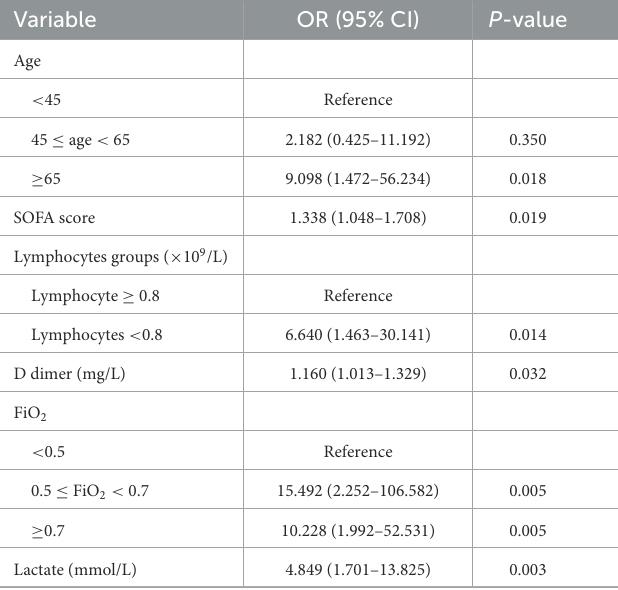
TABLE 4 Risk factors for ICU mortality in immunocompromised patients with severe community-acquired pneumonia.